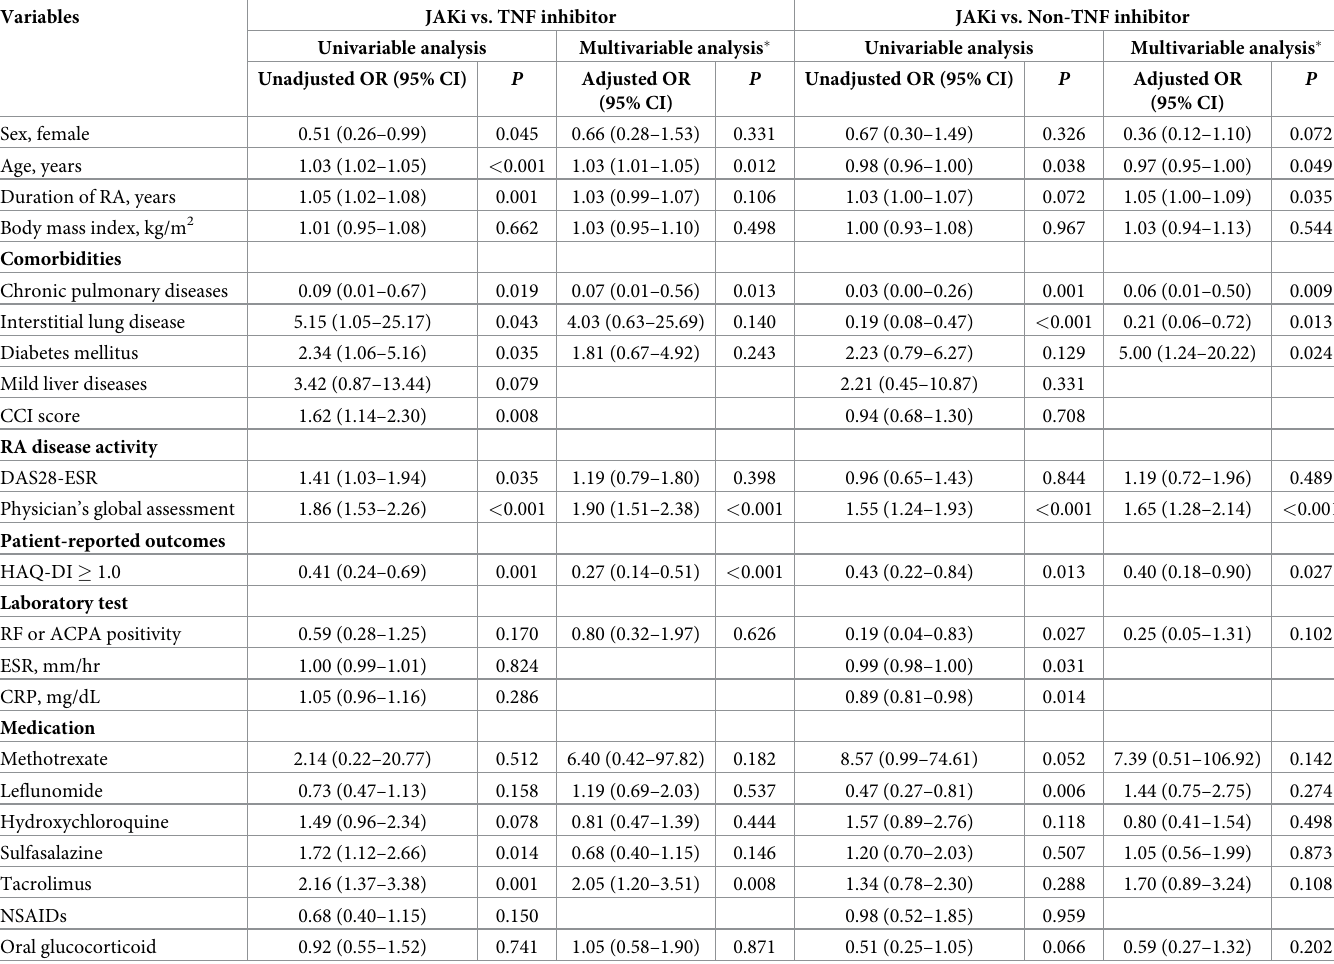
Table 3. Factors for starting JAKi compared with TNF inhibitor or non-TNF inhibitor using multinomial logistic regression (n = 439).